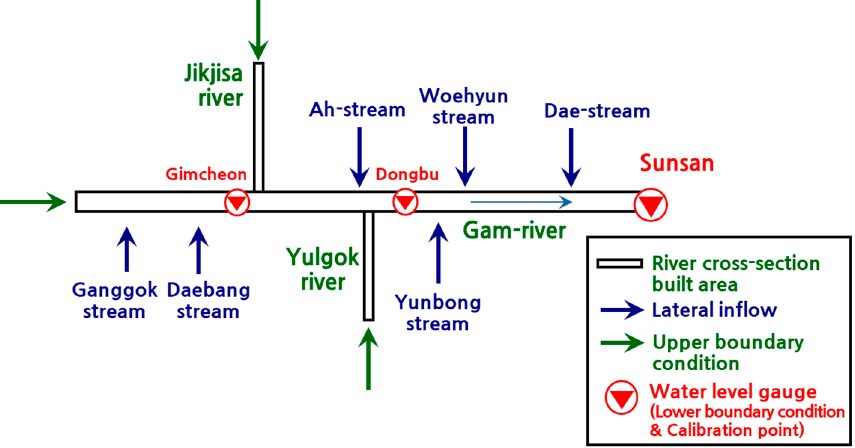
Figure 5. 1-D river system of study area.